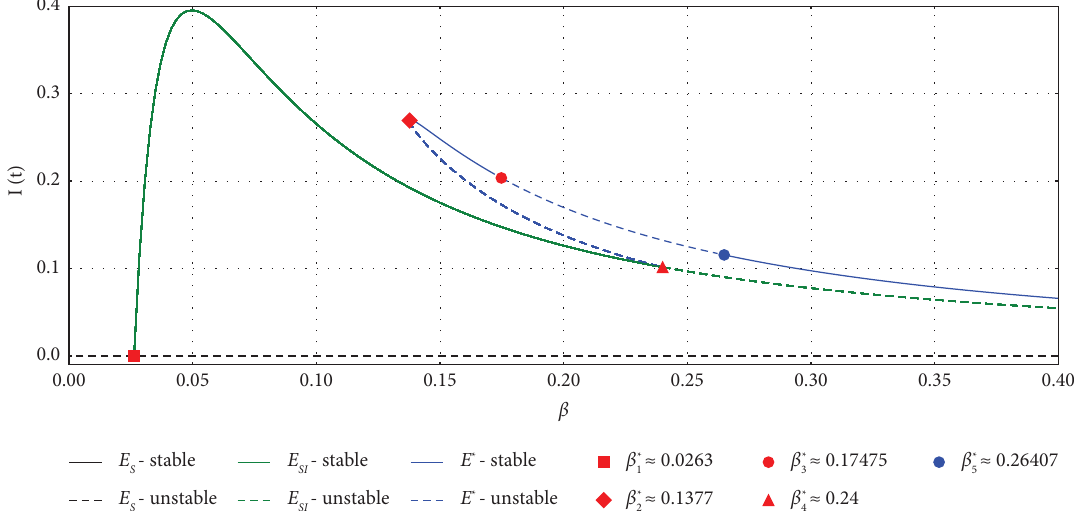
Figure 1: Bifurcation diagram of system (4) driven by β with parameter values (26) and α � 0 .